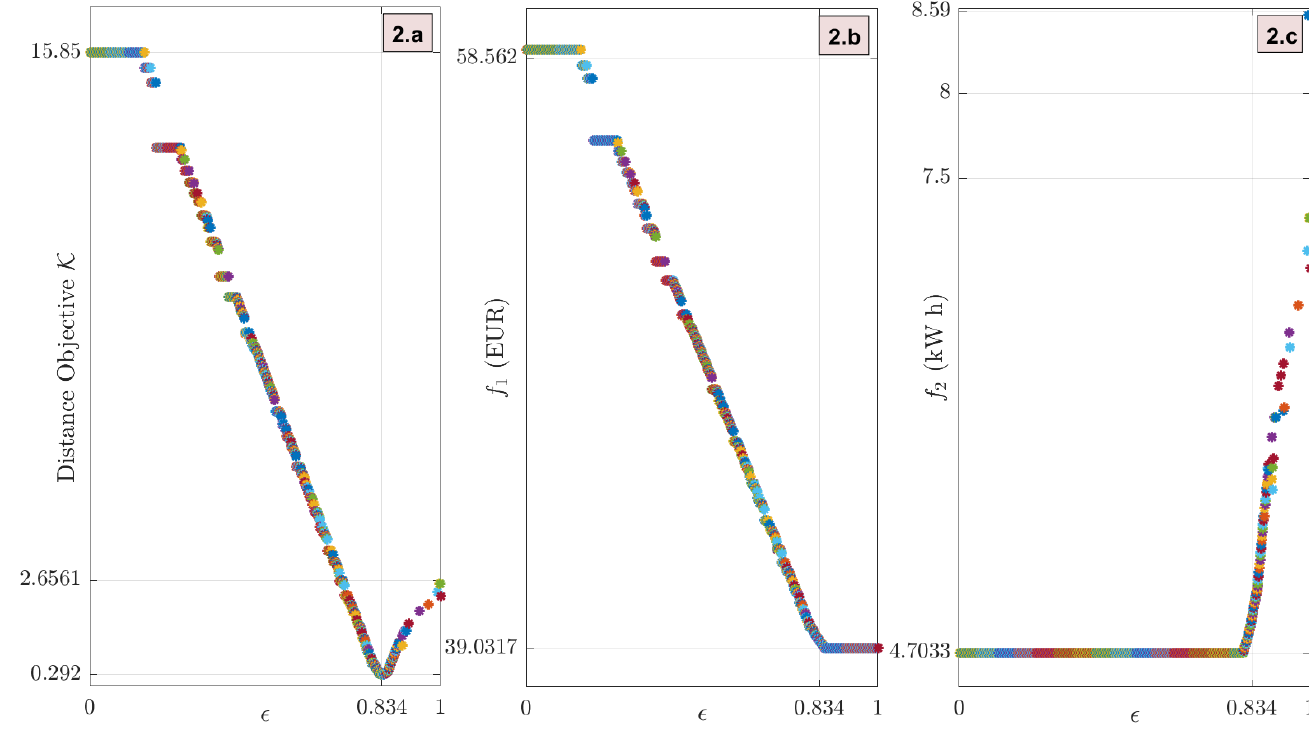
Figure 2. ( a ) Distance of Pareto Points from the Ideal Point, ( b ) Objective Function f 1 respect to (cid:101) , ( c ) Objective Function f 2 respect to (cid:101)